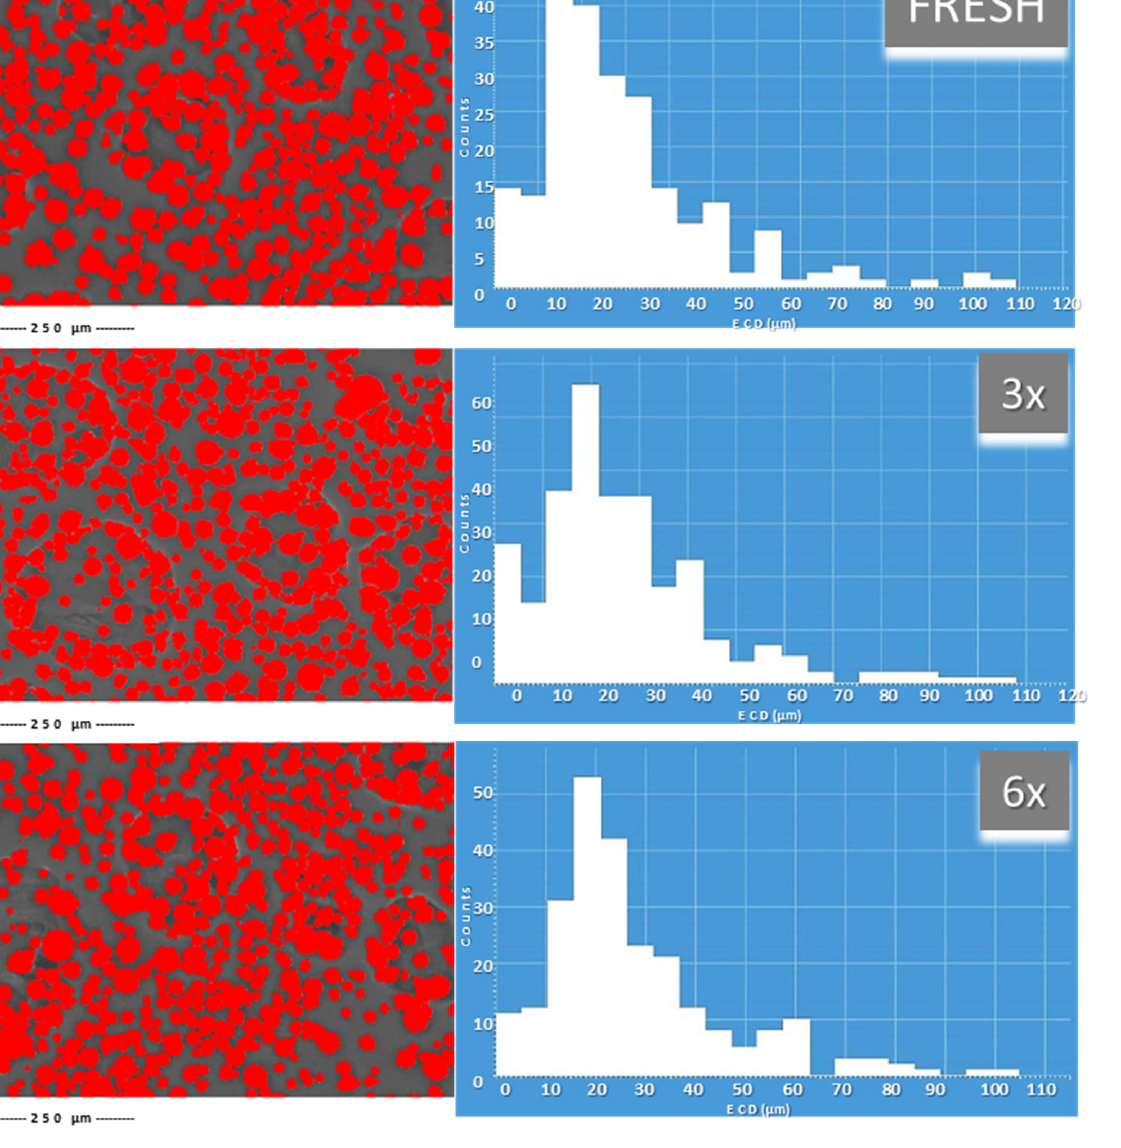
Figure 5. AFPA processing of BSE images for all powders before heat treatment and particle size distribution.